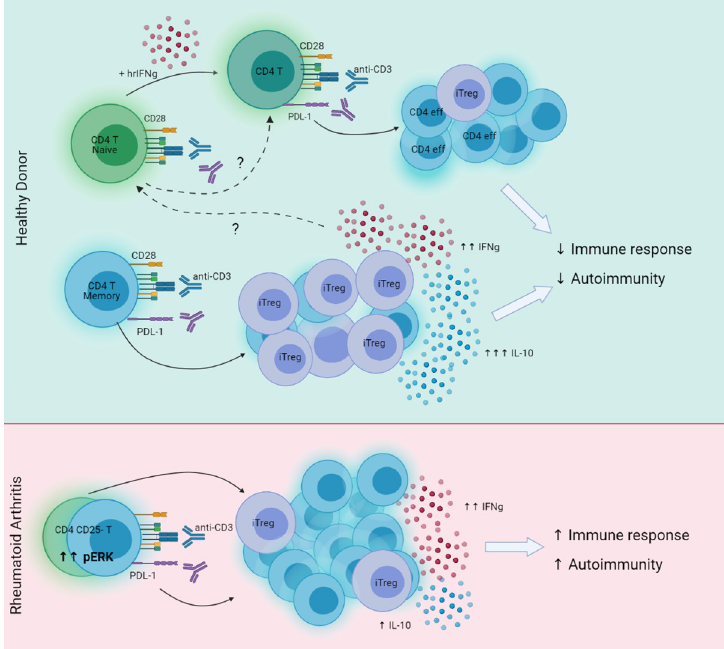
Fig 1. PD-L1 induction of iTregs from human memory CD4 T cells. Healthy donors’ (upper light green level) naive CD4 CD25 − T cells (green cells) and memory CD45RO+CD45RA − CD4 cells (blue cells) were activated with plate- bound anti-CD3 and anti-PD-L1. Memory CD4 cells (blue cells) were the main source of highly suppressive iTreg (violet cells) with high production of IL-10. Same activation of CD4+CD25 − memory and naive T cells from rheumatoid arthritis patients (lower pink level) failed to generate major suppressors of autoimmunity—Tregs. Created with biorender.com. hrIFNg, human recombinant interferon gamma; IFNg, interferon gamma; IL AU : AnabbreviationlisthasbeencompiledforthoseusedinFig 1 : Pleaseverifythatallentriesarecorrect : -10, interleukin 10; iTregs, inducible regulatory T cells; PD-L1, programmed cell death 1 ligand; pERK, phosphorylated ERK.